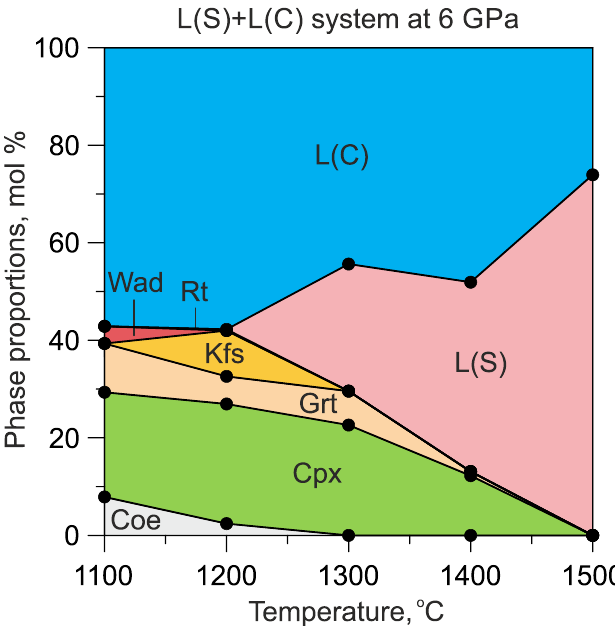
Figure 5. Calculated modes in mole fractions (Table 2) of the phases in the system L(S) + L(C) as a function of temperature at 6 GPa.